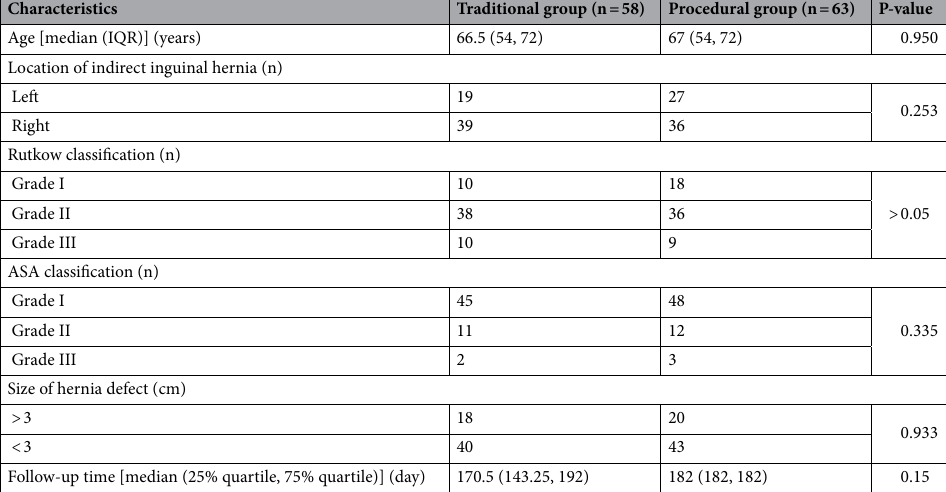
Table 1.. Baseline demographic characteristics in the traditional and procedural groups.